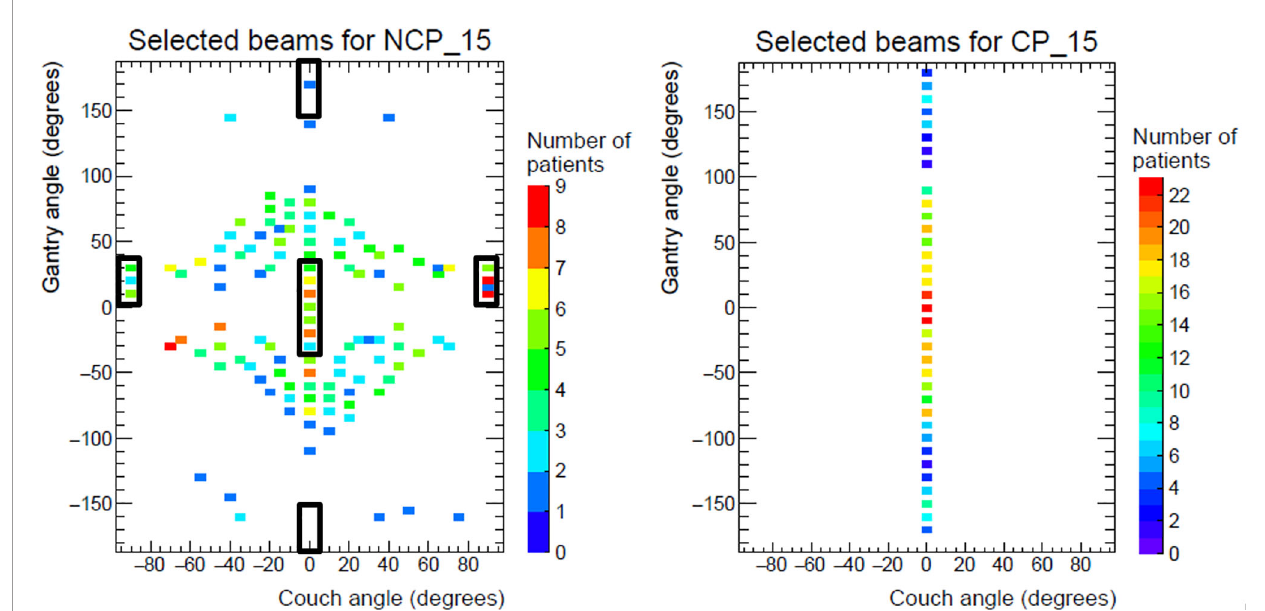
FIGURE 5 | Population distributions of beams selected for NCP_15 (left) and CP_15 (right) for patients 1 to 25 (375 beams per panel). The black rectangles in the left panel indicate the beams present in B-VMAT. Note: B-VMAT beams in the rectangular at couch -90 degrees are in reality delivered with couch angle +90 degrees, while fl ipping the respective gantry angles to negative